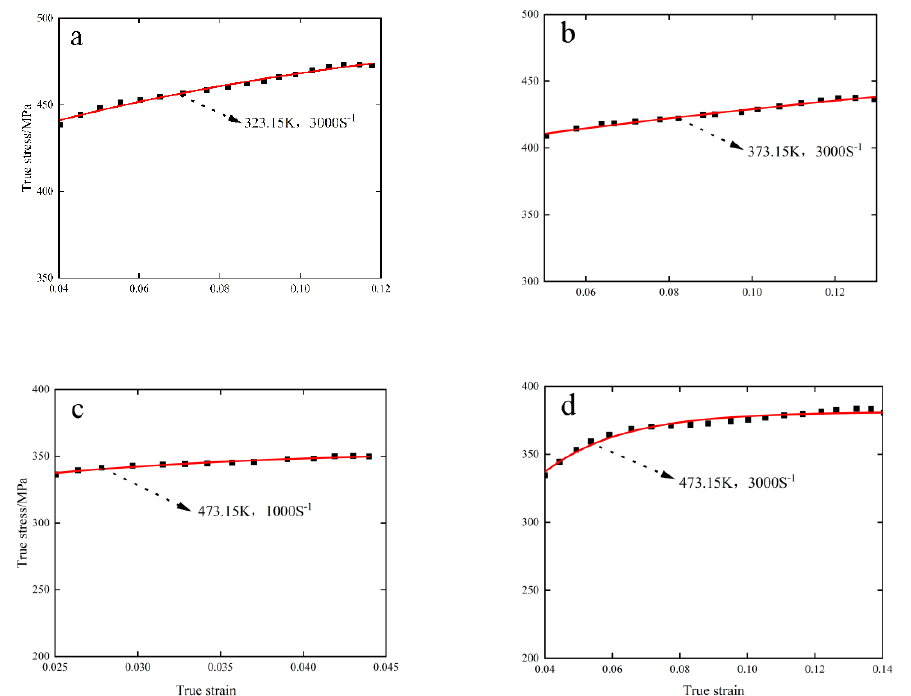
Figure 8. Comparison between experimental curve and fitting curve under different conditions. ( a ) 323.15K,3000S − 1 . ( b ) 373.15K,3000S − 1 . ( c ) 473.15K,1000S − 1 . ( d ) 473.15K,3000S − 1 .